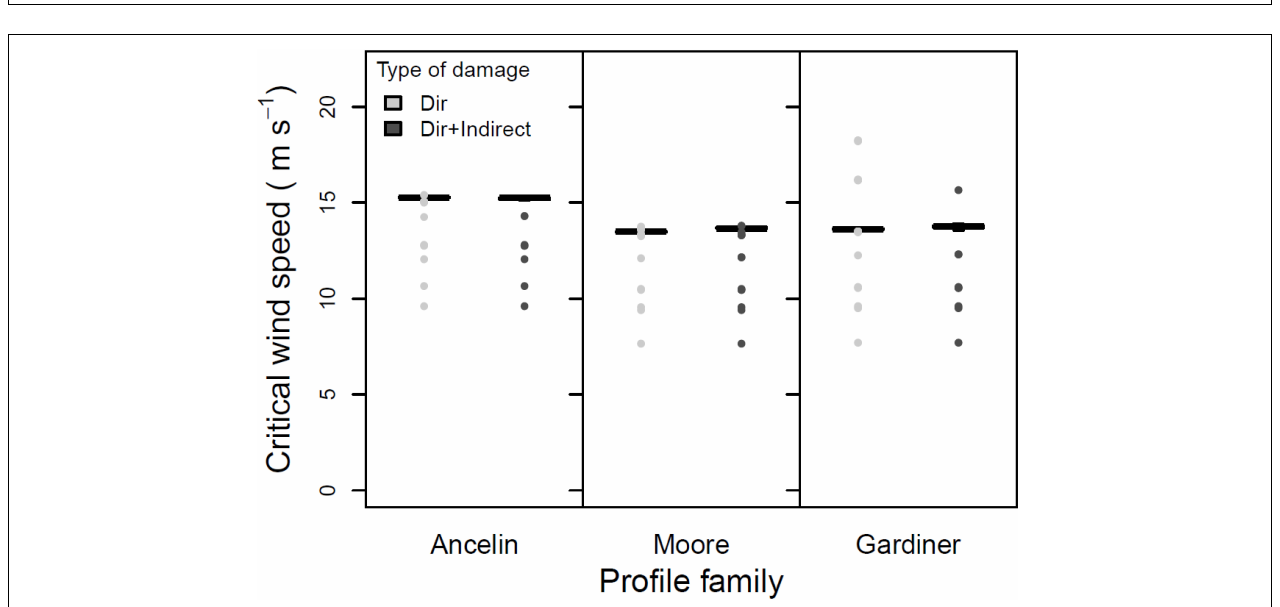
FIGURE 4 | Mean, 25 and 75% percentiles, 1.5 × interquartile range (whiskers), and outliers of critical wind speed (CWS) in m s − 1 , for three profile families and four attenuation factors. For the Ancelin and Moore profile families, the attenuation factor is alpha, with values of 1.5, 3.0, 4.0, and 5.0. For the Gardiner profile family, the attenuation is based on leaf area index (LAI), with values of 2.0, 3.5, 5.0, and 6.5. All other parameters pooled.